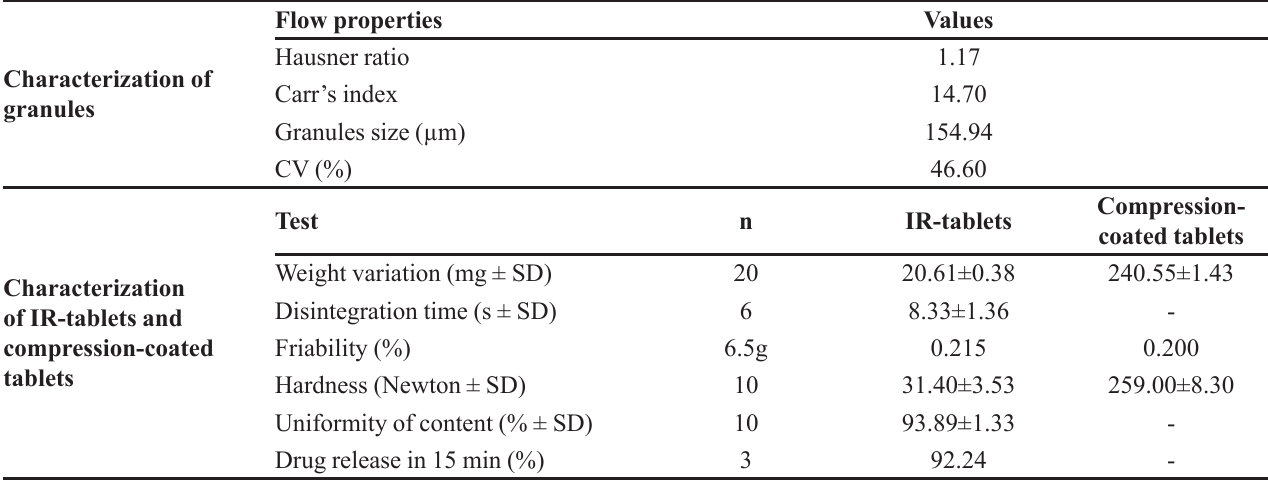
TABLE IV – Characterization of granules, IR-tablets and compression-coated tablets